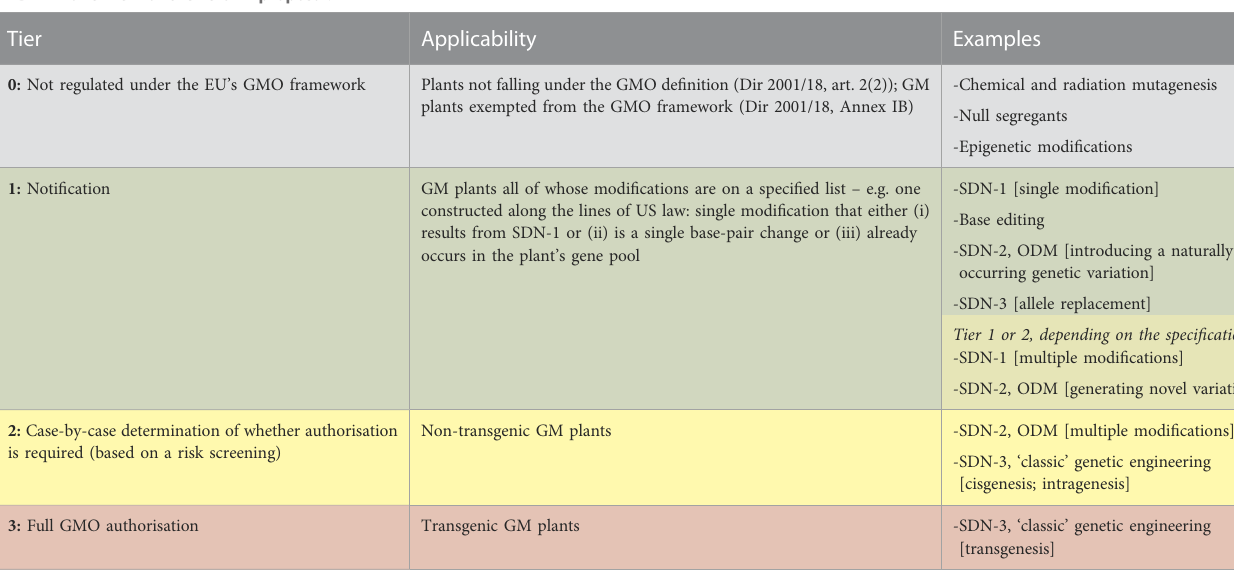
TABLE 1 Overview of the reform